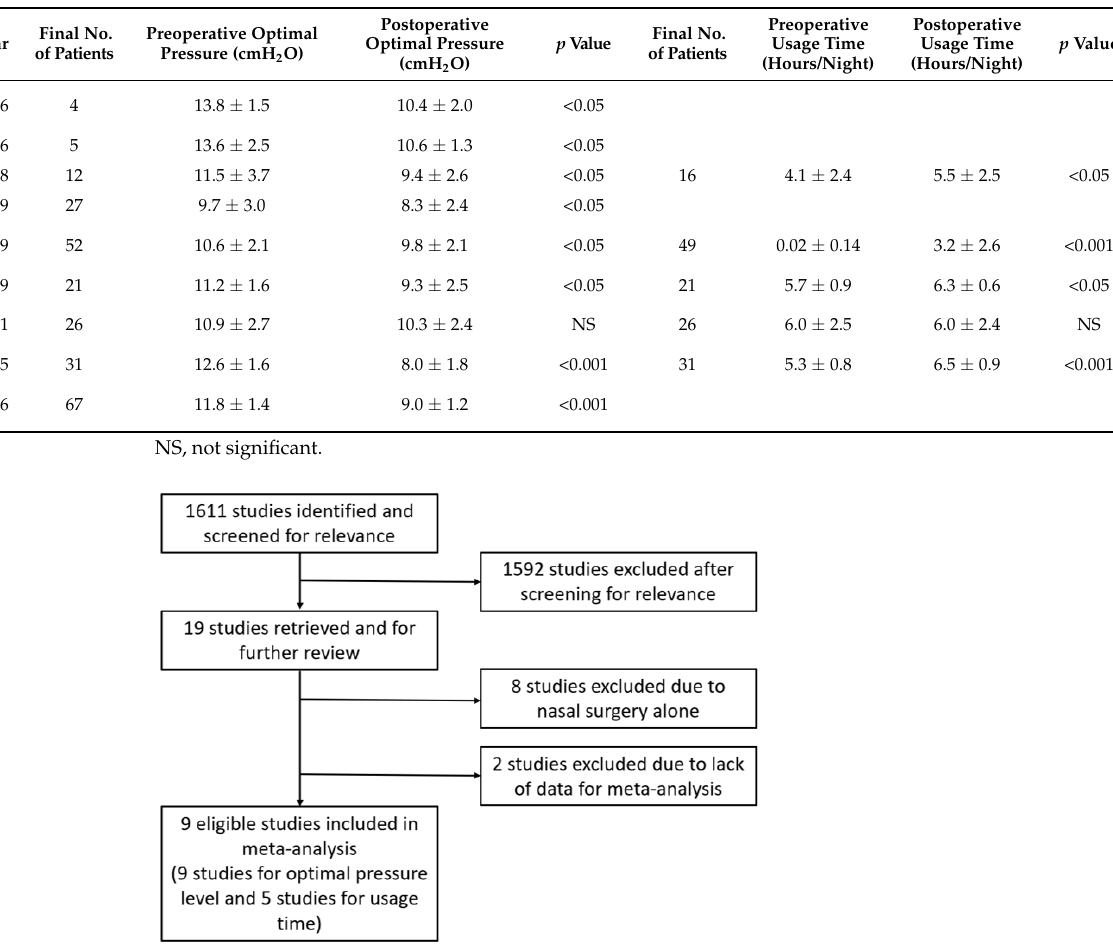
Table 2. Effects of pharyngeal obstructive sleep apnea surgery on positive airway pressure therapy, including optimal pressure and usage time.